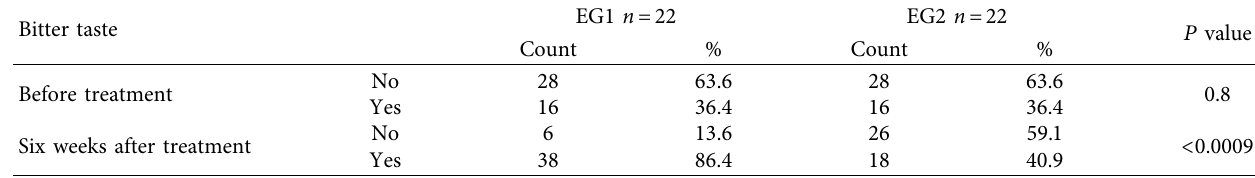
Table 4: Bitter taste results of both groups before and after treatment. Bitter